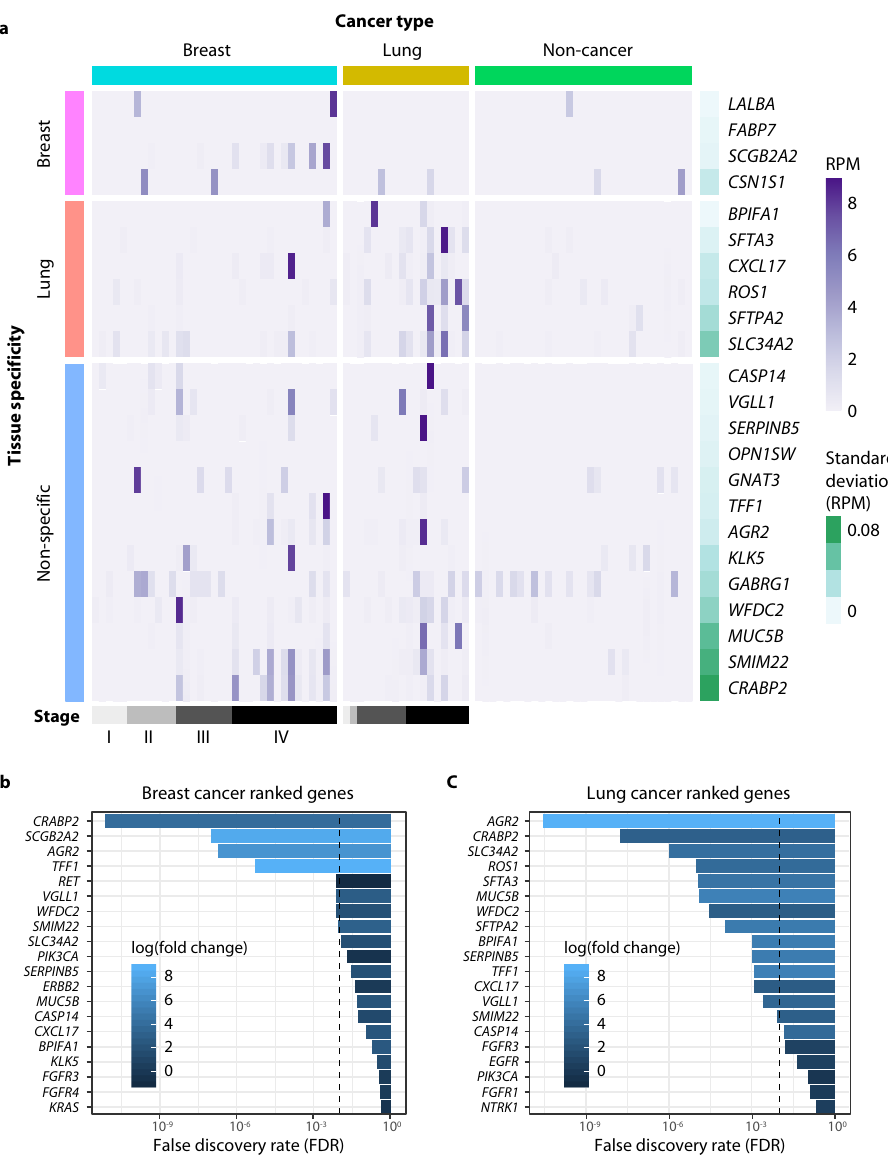
Fig. 6 Detection of dark channel biomarker (DCB) genes in cell-free RNA of an independent validation cohort. a Samples are shown in columns and DCB genes in rows. Cancer type is indicated above the heatmap, and tissue speci fi city of each DCB, as annotated in the Human Protein Atlas (version 18.1), is indicated on the left side of the heatmap. Gene expression values in reads per million (RPM) are represented by the purple gradient and are scaled for visualization purposes. Darkness in non-cancer plasma samples is illustrated by the standard deviation of RPM (green gradient bar) as shown on the right side of the heatmap. False discovery rates (FDR) for the top 20 genes ranked by differential expression analysis of the targeted assay are shown for b breast cancers and c lung cancers. FDR was calculated as the Benjamini-Hochberg corrected P value (using a cut-off of 1% to allow for <1 false-positive across 35